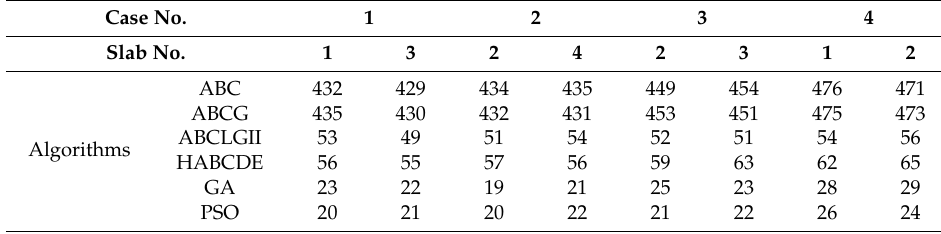
Table 7. Time costs for cases 1 to 4 (unit: